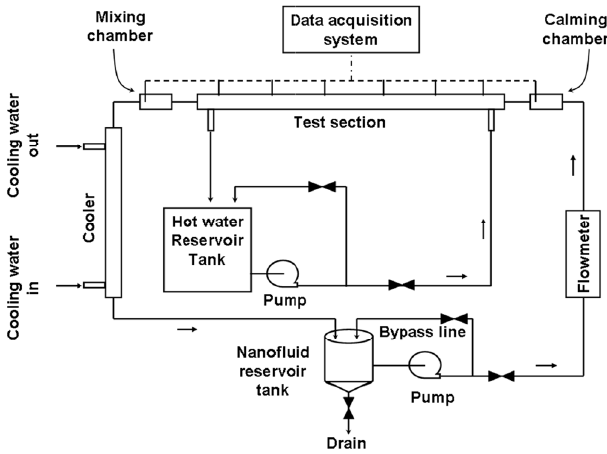
Fig. 1. Experimental setup of data results in